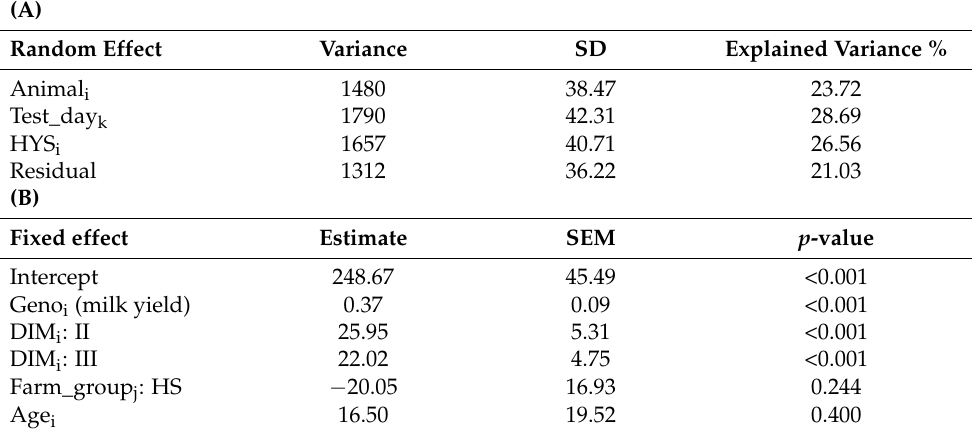
Table 4. ( A ) Random effects, variances, and standard deviations (SD). ( B ) Fixed effects estimates, standard error of the means (SEM) and significance by p -value (Milk